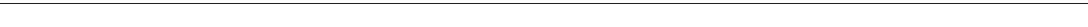
Fig. 4 β 3 integrin expression in early human placenta. a β 3 integrin was detected on multinucleated syncytiotrophoblast cells (STB, cytokeratin-7 + ) and on extravillous trophoblast cells (EVT, HLA-G + ) were found in normal human placental villi from the fi rst trimester of pregnancy (4.5 – 9 weeks). b Western blotting showing expression of β 3 integrin by trophoblast cell line ( right panel ; HTR-8/SVneo and Swan 71) as well as mouse placenta ( left panel ). c At the maternal – fetal interface, fetal allogeneic trophoblast cells interact with maternal killer cells in the decidua. Trophoblasts (glycogen cells) in the junctional zone also showed more interactions with NK cells ( yellow arrows ) in immune mice placenta ( left panel ). These interactions were rare in the decidua of non- immune mice where the NK cells near junctional zone appeared senescent ( right panel ). d uNK cells from both non-immune and immune mice were not proliferating cells ( top panel ). The proliferating cells (Ki67-positive cells) were localized in the labyrinth and their numbers were signi fi cantly reduced in placentas of immune compared to non-immune mice ( bottom panel ). e Non-immune mice had lower levels of α 1 integrin expression ( top panel , left ). Placentas from immune mice showed signi fi cantly upregulated α 1 integrin expression, suggesting stronger tethering of uNK cells to extracellular matrix ( top panel , center ). Anti-asialo-GM-1 treatment reduced uNK cell accumulation ( top panel , right ). Data were collected from eight pregnancies per group. HLA-G marks only extravillous trophoblast, whereas cytokeratin-7, an epithelial cell marker, reacts with both STB and EVT. CTB cytotrophoblast, VS villous stroma. Unpaired Student ’ s t -test. ( a – d ); two-way ANOVA followed by Bonferroni post hoc test ( e ). Mean ± SEM. ** p < 0.01, *** p < 0.001, ns not signi fi cant. Scale bars : 100 μ m ( a , e ) and 50 μ m ( c , d